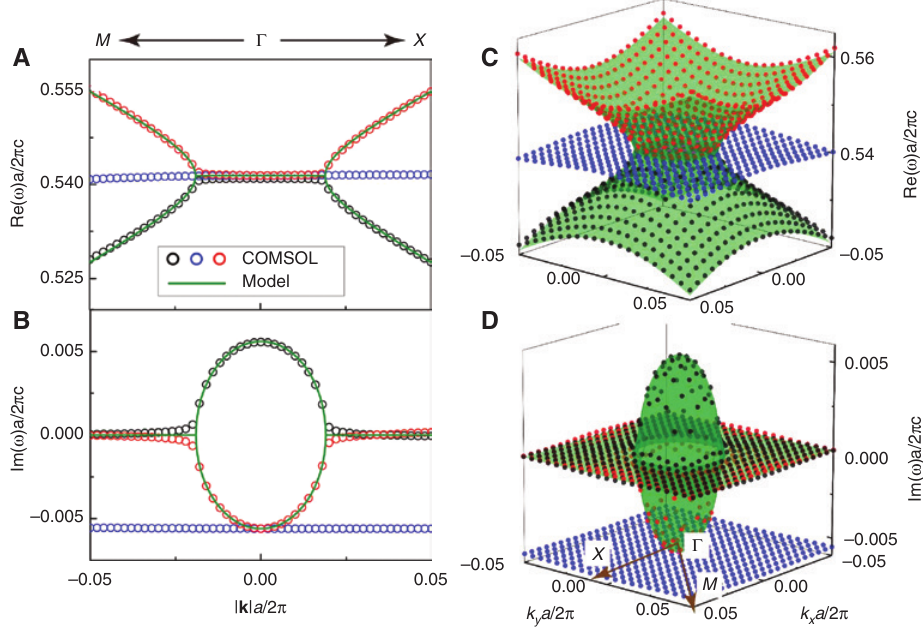
Figure 2: Band dispersions of pseudo-Hermitian bands. The real parts (A and C) and the imaginary parts (B and D) of the complex eigenfrequencies along the M − Γ − X direction and in the 2D Bloch k space. Open circles and solid dots are calculated using COMSOL, whereas green solid lines and green surfaces are calculated using the = 0.295 c and | κ | 2 = 0.00318). The bands outside the ring are entirely real. The parameters of 2D PC are r analytical model ( v g